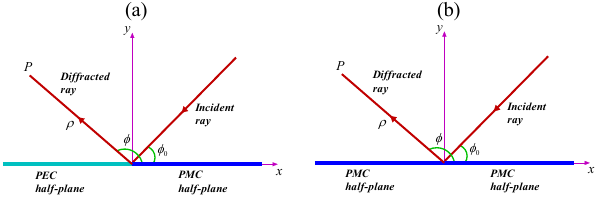
FIGURE 4. The diffraction geometry a) by a planar junction between PMC and PEC half-planes, b) by a planar junction between PMC and PMC half-